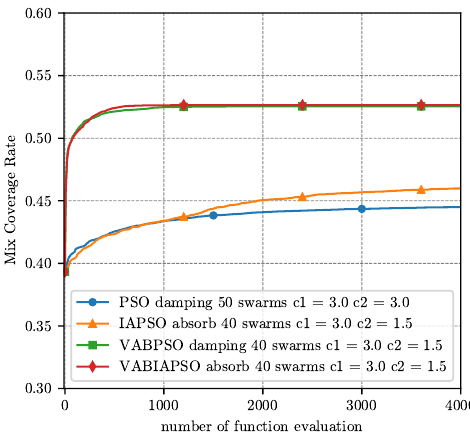
Figure 16. Performance comparison of four algorithms under the optimal parameters of the large- scale random